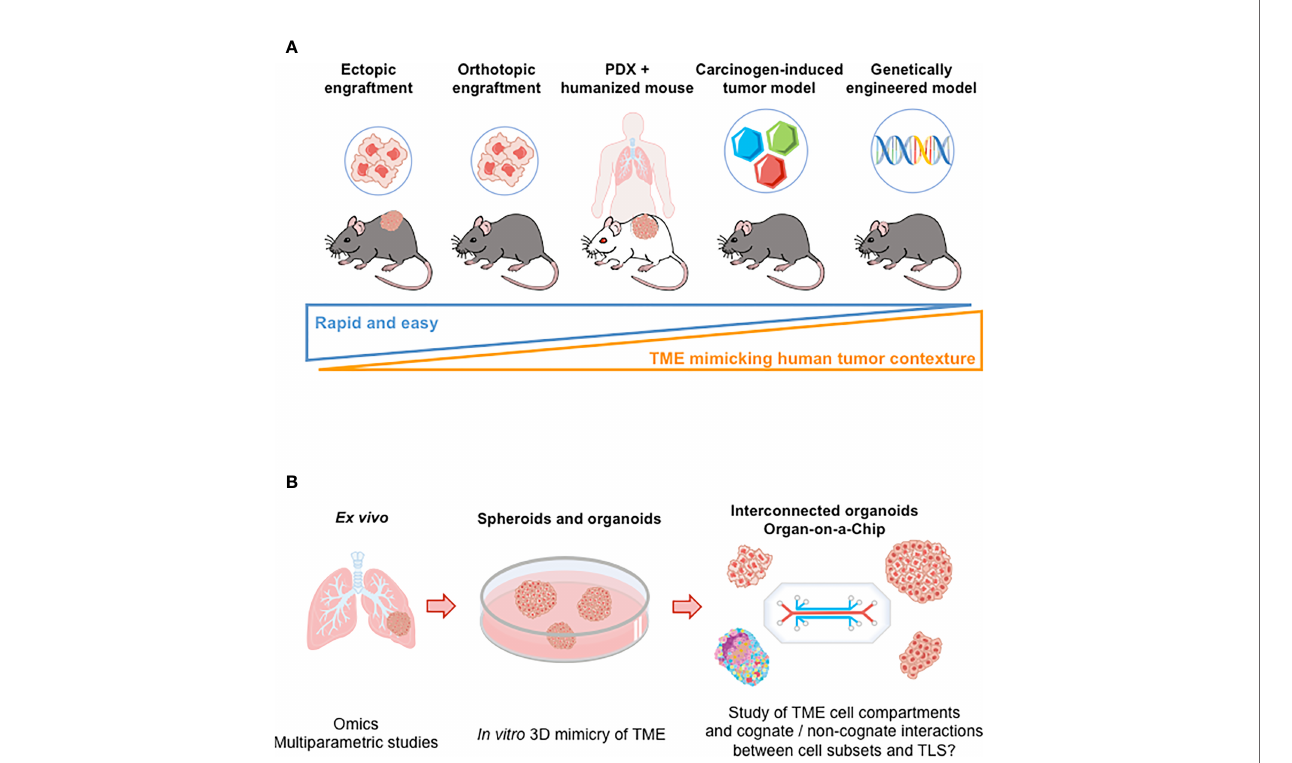
FIGURE 3 | Preclinical models for the study of TLS. (A) Illustration of murine models to investigate of TLS neogenesis and immune function. From the left to the right: i) Ectopic models consist in implanting syngeneic tumor cells in immunocompetent mice (subcutaneous injection). However, tumor microenvironment poorly recapitulates the immune contexture of the originating tissue; ii) Intravenous injection of tumor cells allow tumor cells to disseminate in various tissues. But TLS study is hard to perform (kinetics of tumor growth and of TLS neogenesis to be mastered); iii) Implanting tumor cells directly into the tissue from which they originate (orthotopic models) allows tumor growth in a more physiological relevant microenvironment but without rapid dissemination; iv) Patient-Derived Xenotransplantation (PDX) tumor models that use immunode fi cient mice enable a better maintenance of tumor heterogeneity but do not allow to investigate anti-tumor immune responses. Mice repopulated with human immune cells ( “ humanized mice ” ) can be used; v) Carcinogen-induced and genetically engineered tumor models better mimic the clinical situation. Tumors develop spontaneously and gradually in the targeted tissue, allowing for progressive immune microenvironment formation. However, an important variability in tumor development is observed (requirement for large numbers of animals to conduct experiments). (B) Ex vivo and in vitro models, as illustrated in lung cancer. Tumor explants enable to perform multiparametric cytometry and/or imaging, bulk or single cell RNAseq, providing data on the cellular and molecular content of TME. Spheroid and organoid cultures derived from tumor tissues allow the study of TME cellular components (or even of more complex structures such as TLS in a near future following recent progress in organoid and interconnected organoid techniques) (82). “ Organ-on-a-Chips ” (i.e., micro fl uidic tissue chips) devices make it possible to study the interaction between TME cell compartments (tumor, stromal, and immune cells). TME, tumor